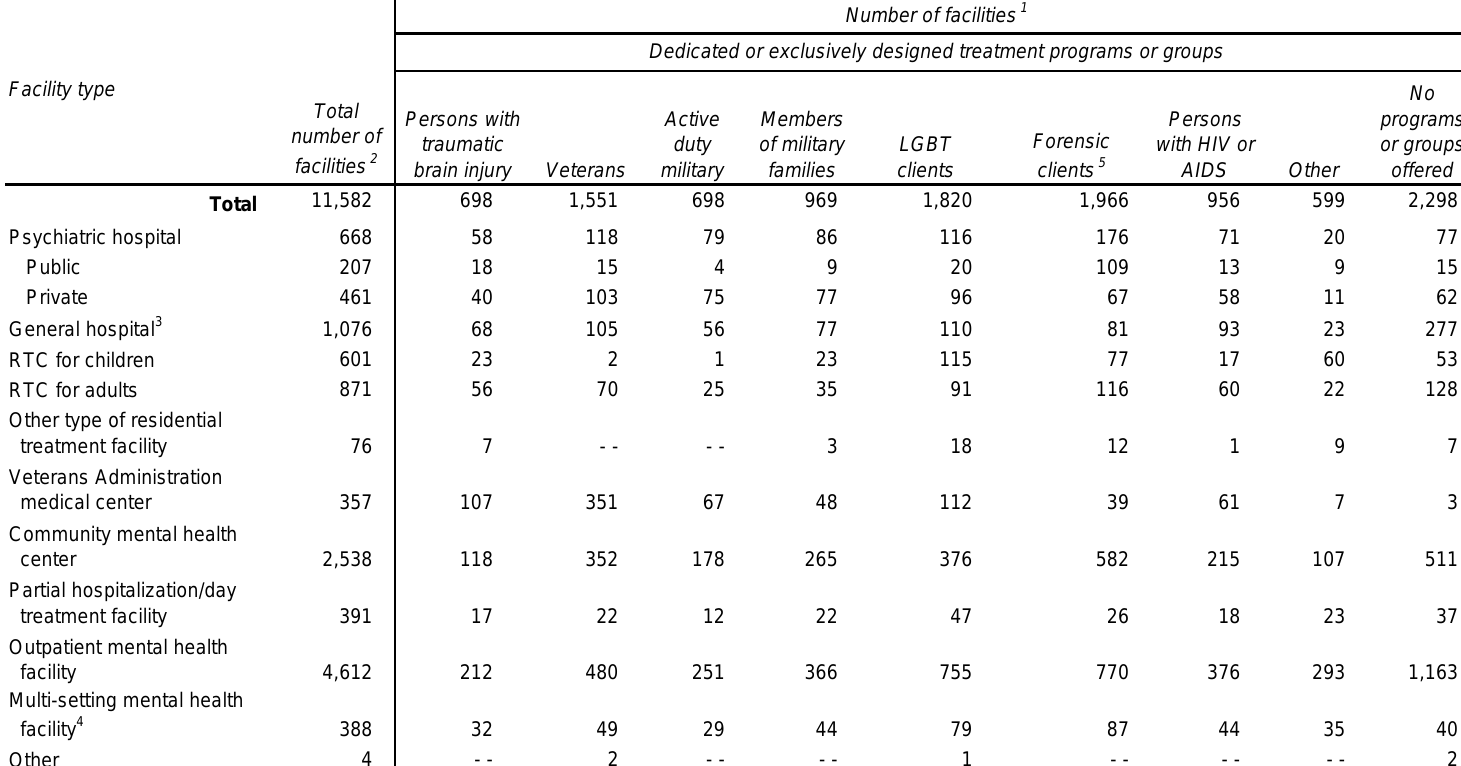
Table 2.6a. Mental health treatment facilities offering treatment programs or groups dedicated or exclusively designed for specific client categories, by facility type: Number, 2017